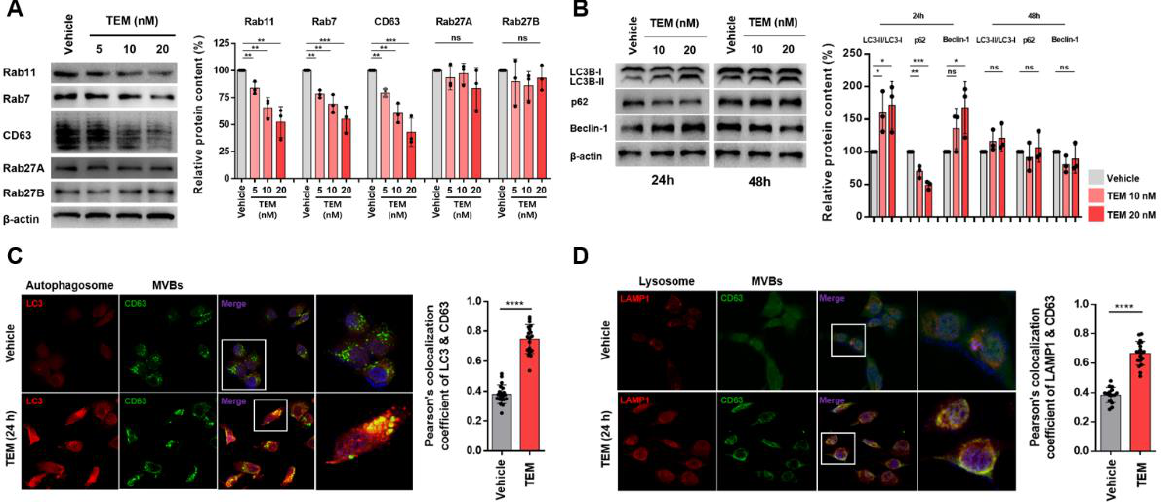
Figure 2. Temsirolimus (TEM) induces degradation of multivesicular bodies (MVBs) through regu- lation of Rab proteins and activation of autophagy. ( A , B ) The immunoblots of various proteins are associated with ( A ) small extracellular vesicle (sEV) secretion and ( B ) autophagy in MDA-MB-231 cells. ( left ) ( n = 3). β -actin was used as the loading control. The quantitative analysis of the relative protein expression ( right ). ( C ) Confocal microscopy image. Colocalization of LC3 (autophagosome) and CD63 [(multivesicular bodies (MVBs)] in MDA-MB-231 cells by TEM treatment. ( D ) Confocal microscopy image. Colocalization of LAMP1 (lysosome) and CD63 (MVBs) in MDA-MB-231 by TEM treatment. The colocalization was estimated using Pea rson’s correlation coefficient. The data are presented as means ± standard deviation (SD) using an unpaired two-tailed S tudent’s t -test. * p < 0.05, ** p < 0.01, *** p < 0.001, and **** p < 0.0001, respectively; ns, not significant. sEV PD-L1 can induce immunosuppression by binding to PD-1 on the surface of CD8 + T cells through body circulation [13,19]. Thus, we performed a CD8 + T cell-mediated cancer cell killing assay to confirm that TEM treatment can increase the CD8 + T cell-medi- ated anti-cancer effect by inhibiting the secretion of sEV PD-L1. In the co-culture of acti- vated CD8 + T cells and 4T1 cancer cells, TEM alone or in combination with anti-PD-L1 improved CD8 + T cell-mediated cancer cell killing. On the contrary, TEM alone or in com- bination with anti-PD-L1 antibodies did not exhibit a direct cytotoxic effect on 4T1 cells (Figure 3A). These results suggest that TEM increased the activity of CD8 + T cells by in- hibiting sEV PD-L1 secretion, and anti-cancer effects were exhibited owing to an additive effect with anti-PD-L1. We also performed a cytokine ELISA to confirm whether TEM alone or in combination with anti-PD-L1 induced the activation of CD8 + T cells. Tumor growth may be inhibited by the pro-inflammatory milieu generated by effector cytokines such as TNF- α, which are released by CD8 + T cells [31]. In the co-culture of activated CD8 + T cells and 4T1 cancer cells, TEM alone or in combination with anti-PD-L1 effectively in- creased the release of TNF- α from CD8 + T cells (Figure 3B). These results suggest that TEM can induce CD8 + T cell-mediated anti-cancer effects by inhibiting the secretion of sEV PD- L1 in cancer cells and promoting the release of cytokines, such as TNF- α, in CD8 + T cells.